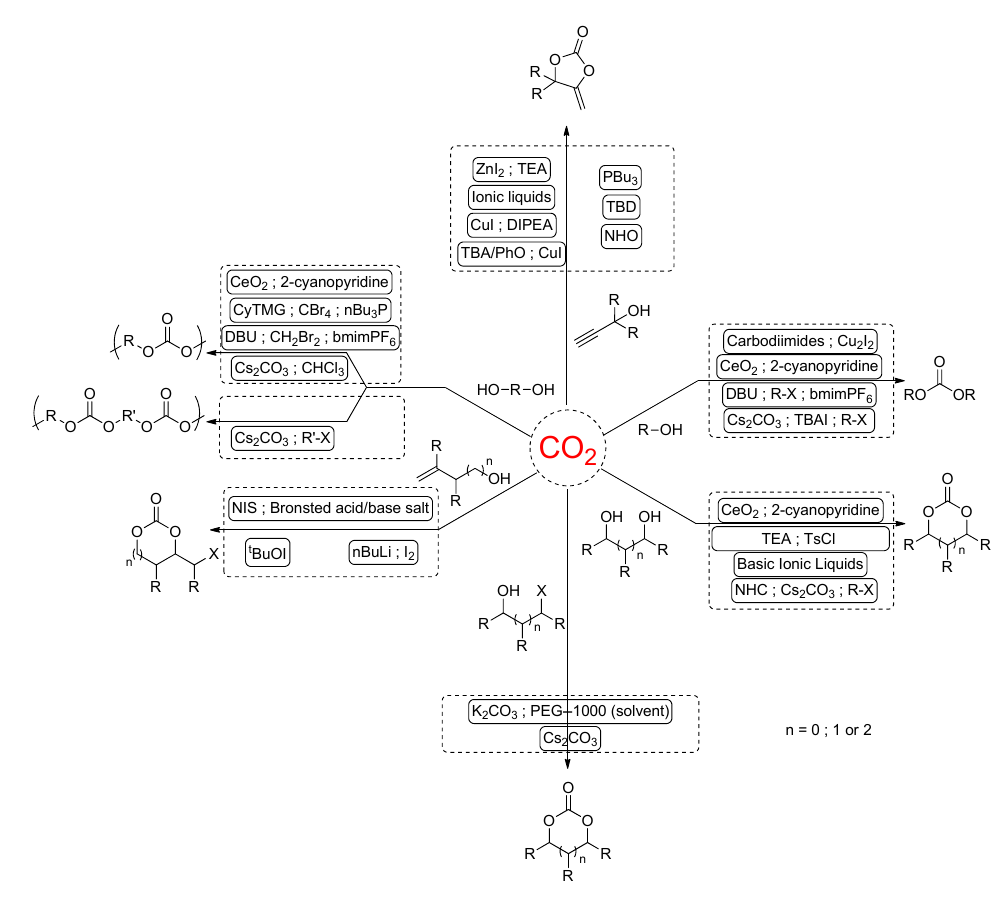
Scheme 1. Main strategies used to afford (a)cyclic carbonates and polycarbonates from the coupling of alcohols and CO 2